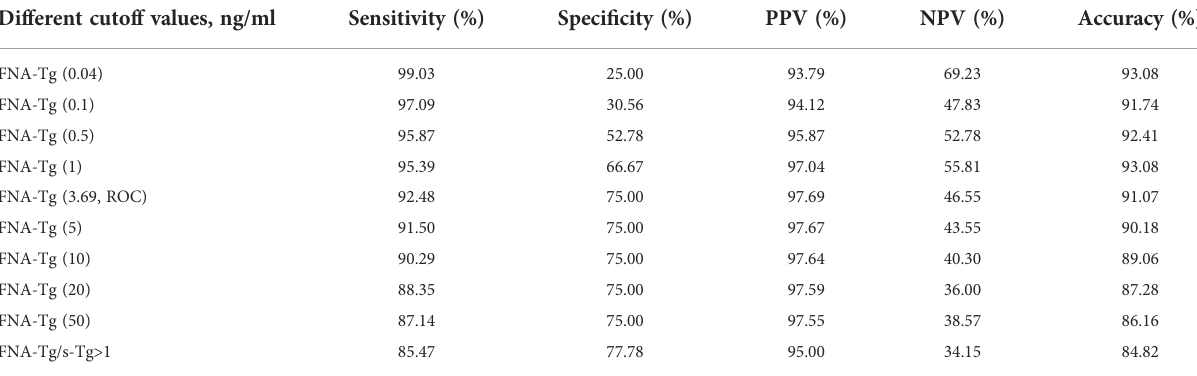
FNA-Tg, The measurement of thyroglobulin on the fi ne-needle aspiration; PPV, Positive predictive value; NPV, Negative predictive